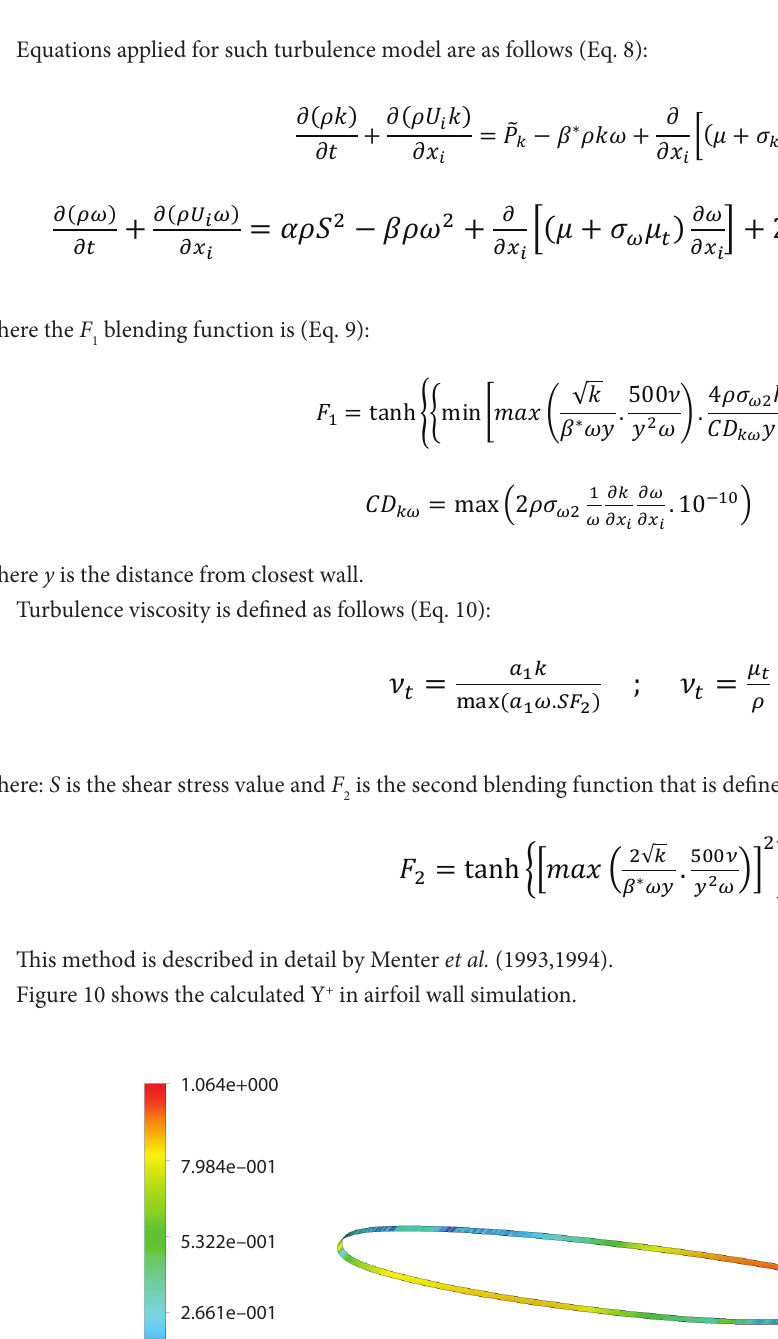
Figure 10. Y + calculated on the airfoil wall.